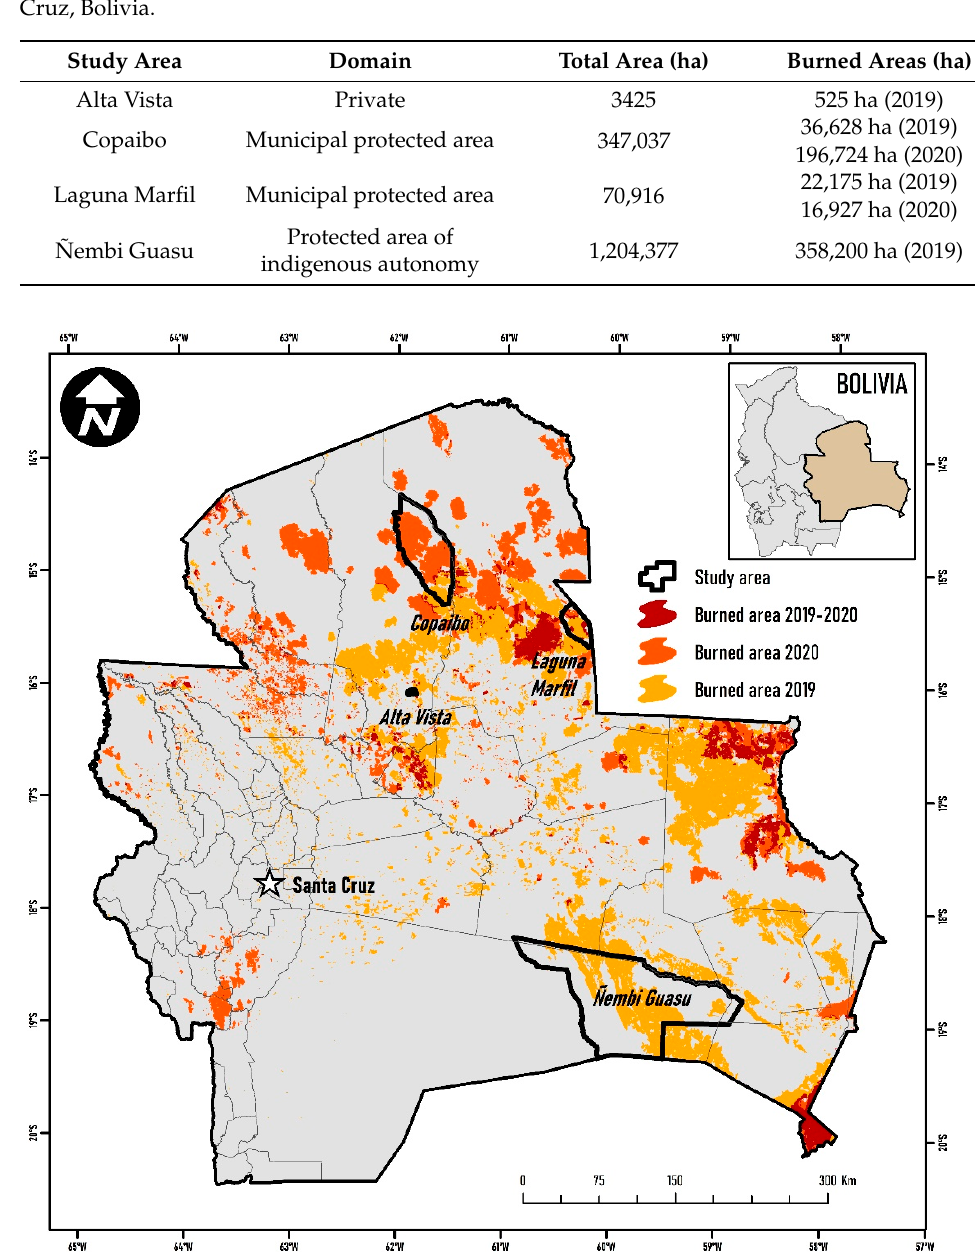
Table 1. Surface of burned areas in the four study sites in 2019 and 2020, Department of Santa Cruz,